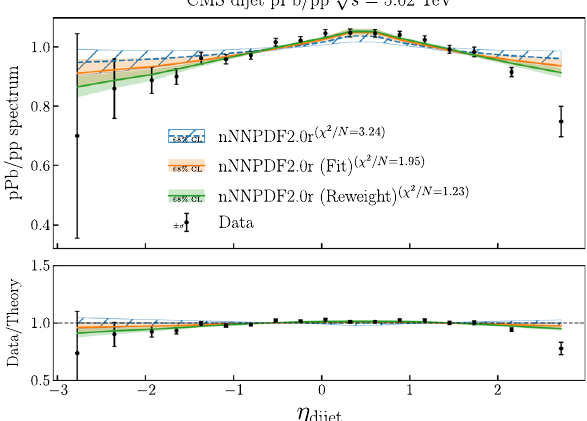
Fig. 35 Comparison between the theoretical predictions based on nNNPDF2.0r and on two variants where the first bin (55 < p avg 75 GeV) of the CMS dijet ratio data has been added either via direct inclusion in the fit or by means of Bayesian reweighting. The band in the theory prediction indicates the PDF uncertainty, while the bottom panels display the ratio to the central theory prediction. No estimate of uncertainties due to MHOs are considered in this comparison. We also indicate in the legend the corresponding values for the χ 2 / n dat in each